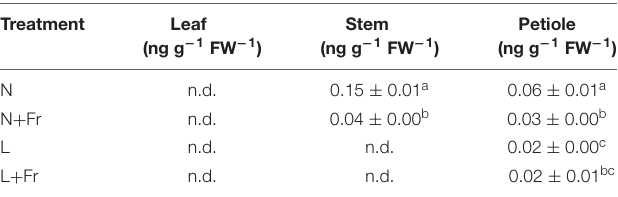
TABLE 2 | Gibberellin 4 (GA4) levels in different tissues (leaf, stem, and petiole) of soybean seedlings harvested after 15 days under different light intensity and quality treatments.